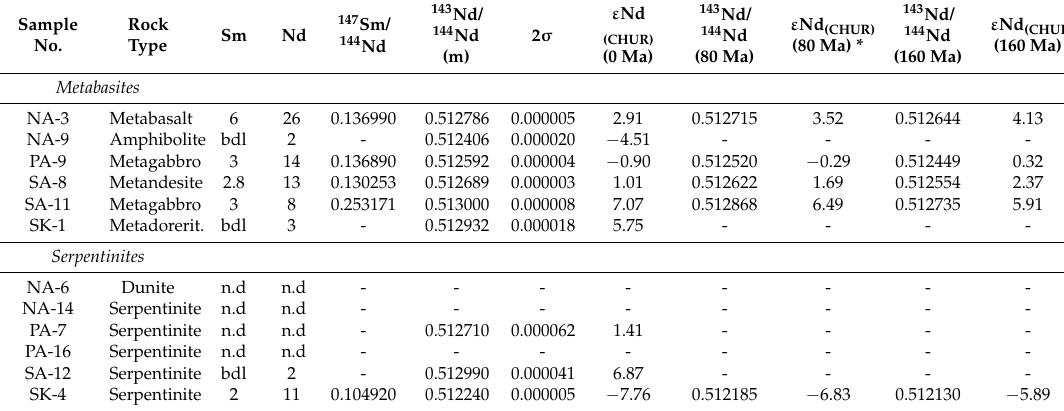
n.d: not detected, bdl: below detection limit. * 80 Ma is the reported age of Samos metagabbros from [15]. 87 Rb/ 86 Sr and 147 Sm/ 144 Nd isotopic ratios were calculated on the basis of whole rock Rb/Sr and Sm/Nd ratios (concentrations from XRF analysis), using the applications of GCDKit 4.0 software [81] and equations of [82].